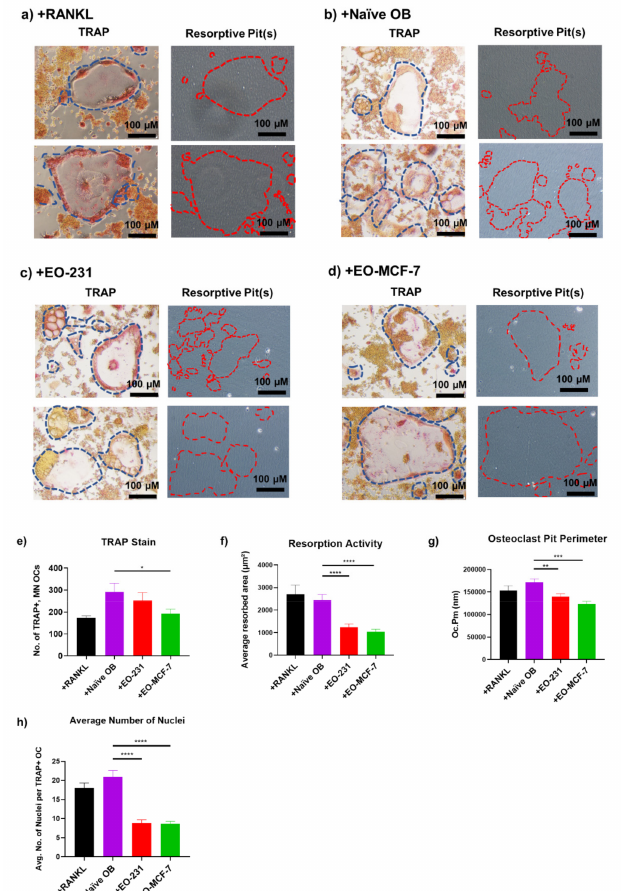
Figure 3. Osteoclasts produced in the presence of EO cells have decreased resorptive activity and reduced pit perimeter. RAW 264.7 pre-osteoclasts were co-cultured on a bone mimetic matrix with either ( a ) 50 ng/mL RANKL (control), or in the presence of 50 ng/mL RANKL under the following conditions: ( b ) naïve OBs (control), ( c ) EO-231, or ( d ) EO-MCF-7. After six days, cultures were stained for TRAP (pink color; blue outlines), a common marker for mature osteoclasts. Formation of resorptive pits were also observed (red outlines) and matched to the corresponding TRAP picture for each condition. Representative images are displayed per condition. The number (No.) of TRAP- positive, multinucleated ( ≥ 3 nuclei) mature osteoclasts ( e ), resorptive area ( f ), osteoclast pit perimeter (Oc.Pm) ( g ), and the number of nuclei per TRAP-positive, multinucleated ( ≥ 3 nuclei) osteoclast ( h ) were quantified for each condition. Three individual batches were assayed per condition. TRAP and resorptive pits were visualized via light microscopy. Scale = 100 µ M. N = 3. * p < 0.05; ** p < 0.01; *** p < 0.001; **** p <